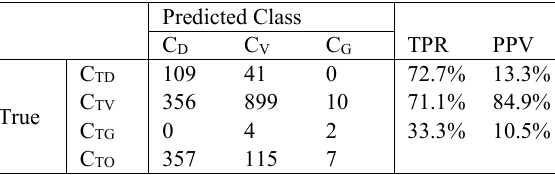
Table 3 . Classification performance: confusion